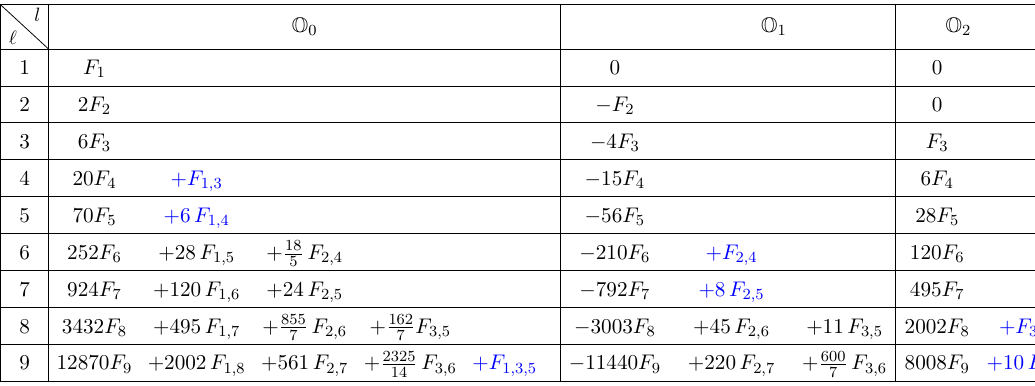
Table 2 . Octagons up to nine loops for bridges l = 0 , 1 , 2 . In order to restore the coupling and 10 D character we make the rescaling F single-determinant cases given by the close formulas